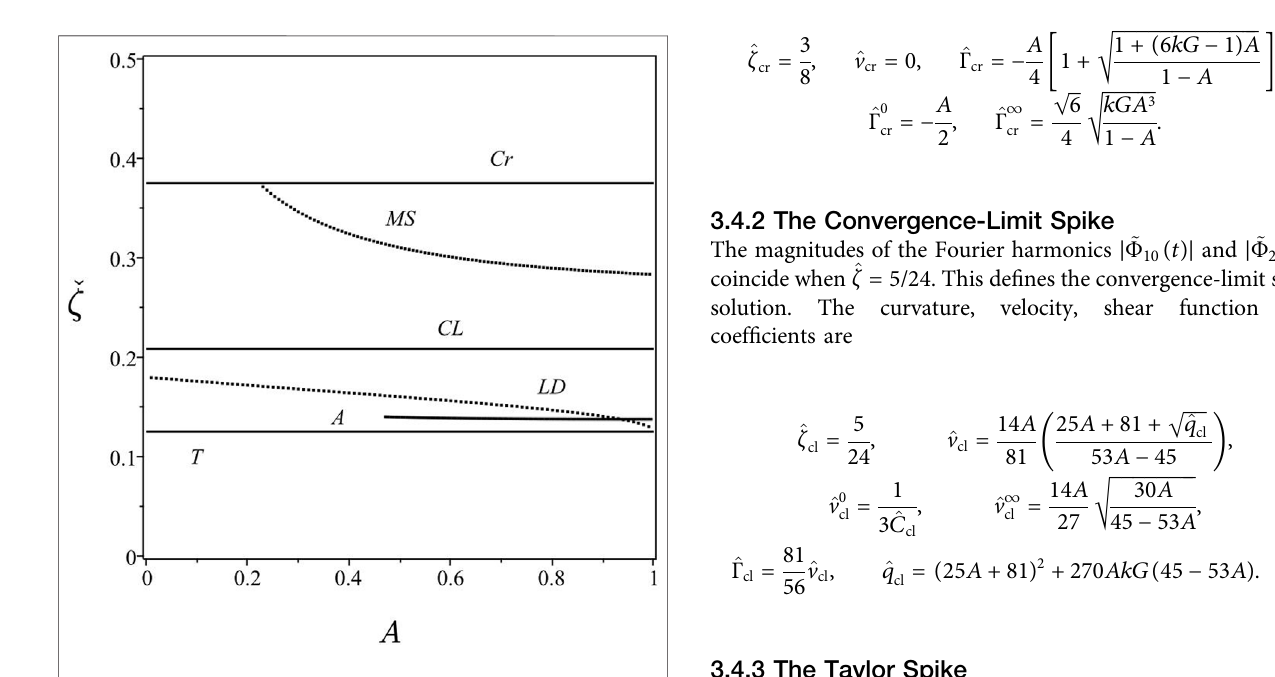
FIGURE7| ScaledcurvatureasafunctionoftheAtwoodnumberforthe critical (Cr), convergence-limit (CL), Taylor (T), minimum-shear (MS), Layzer- drag (LD) and Atwood (A) bubbles for kG (cid:1)